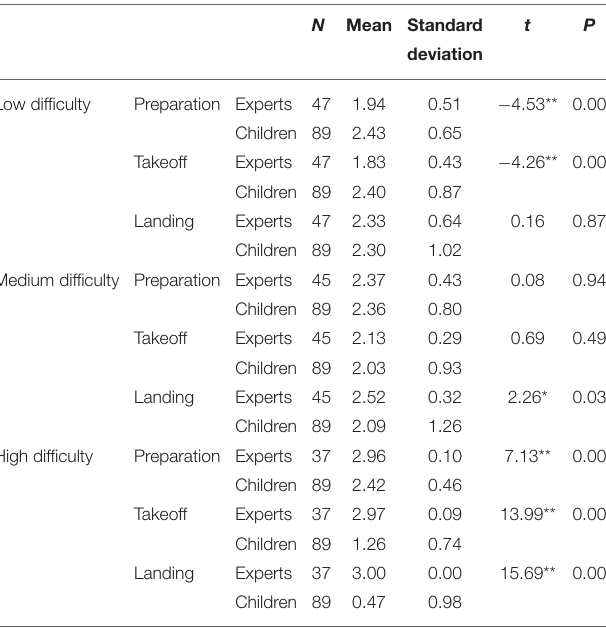
TABLE 10 | Comparison of jumping motor performance between experts and children at different stages in tasks with different difficulties. N Mean